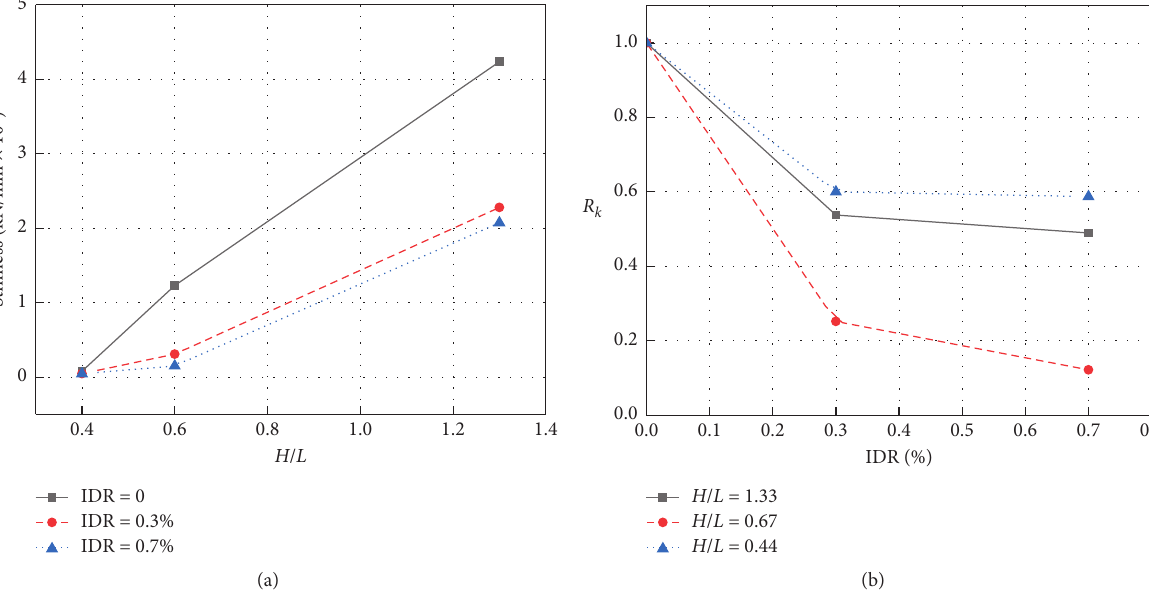
Figure 16. The slenderness ratio plays a most important role on the interaction of IP and OOP performance of the infill wall. However, the influence of masonry strength and aspect ratio is not that obvious. The reduction factors of the infill wall with different slenderness ratios tend to approximate the value in the New Zealand code [35] with IDR increasing.